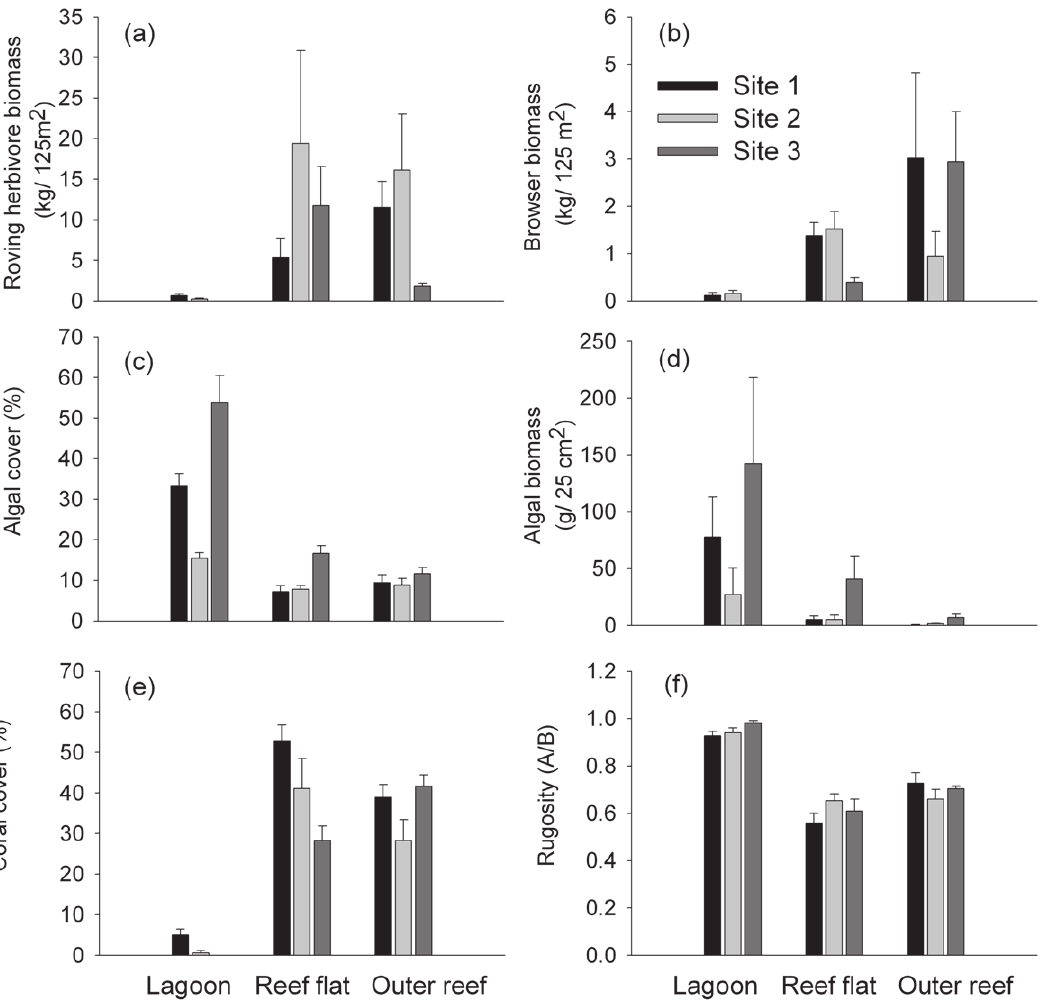
Figure 2. Seascape patterns in the distribution of herbivores, macroalgae, coral cover and rugosity. Data represent means 6 SE of (a) total roving herbivorous fish biomass, (b) total browsing fish biomass, (c) algal cover, (d) algal biomass, (e) coral cover, and (f) rugosity.